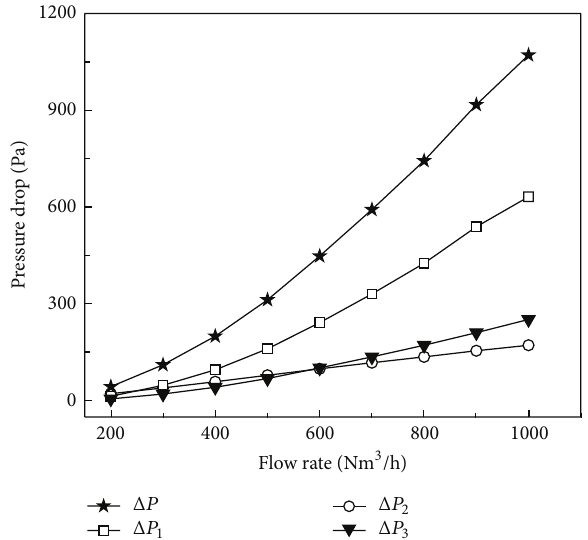
Figure5:Pressuredropdistributioninpreheatedcatalyticoxidation reactor with different flow rates. Figure 6: Resistance proportion distribution with different flow